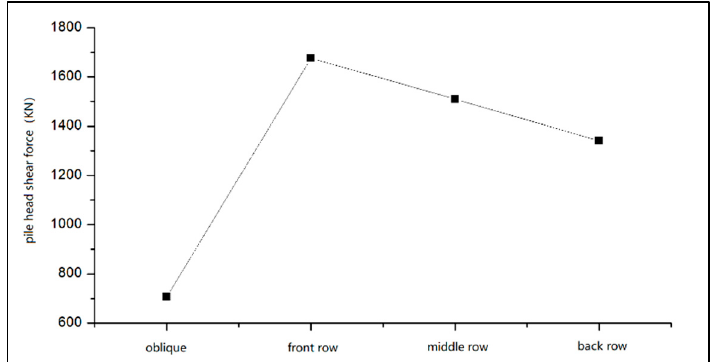
Figure 15. Shear force diagram of pile top under design load.